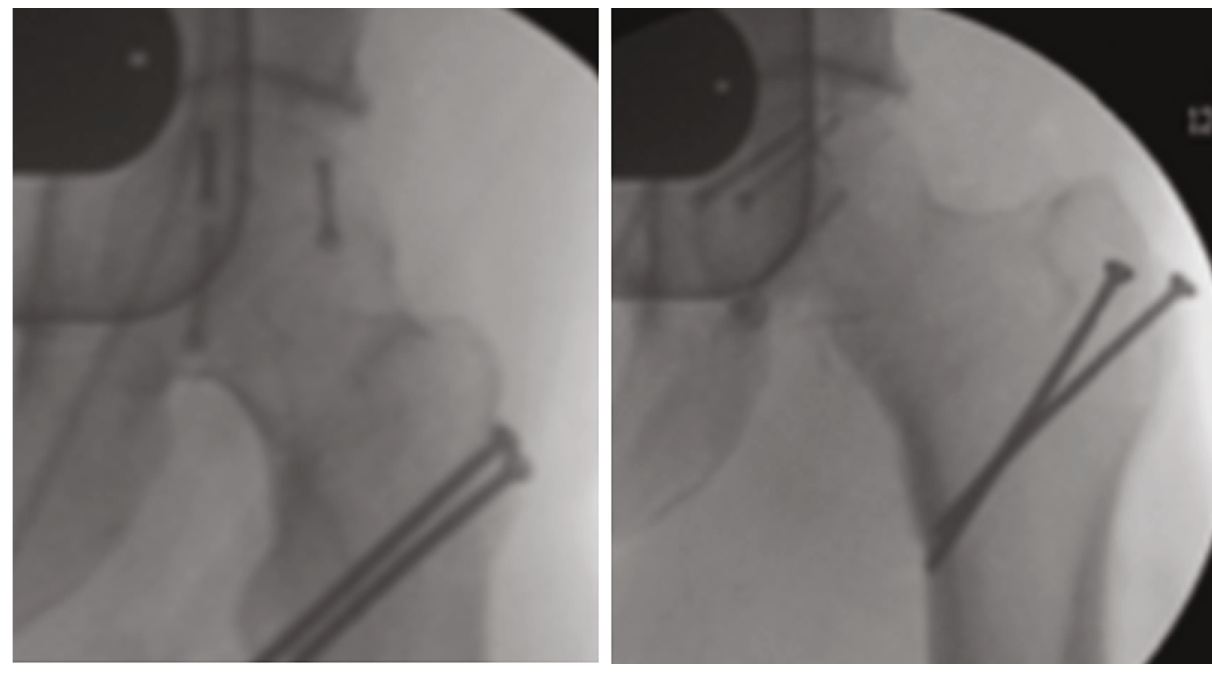
Figure 4: Trochanteric fi xation with two 3.5mm cortical